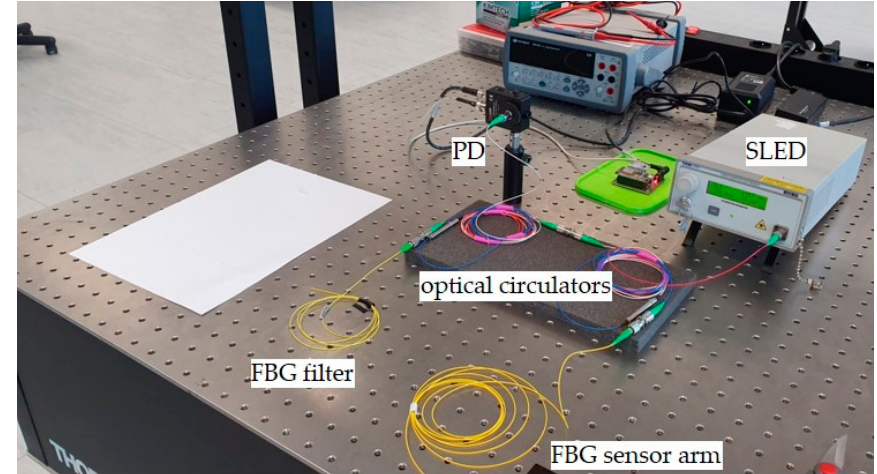
Figure 10. Laboratory version of the interrogator used for overhead transmission line wire sag measurement. SLED: superluminescent light-emitting diode; PD: photodetector.